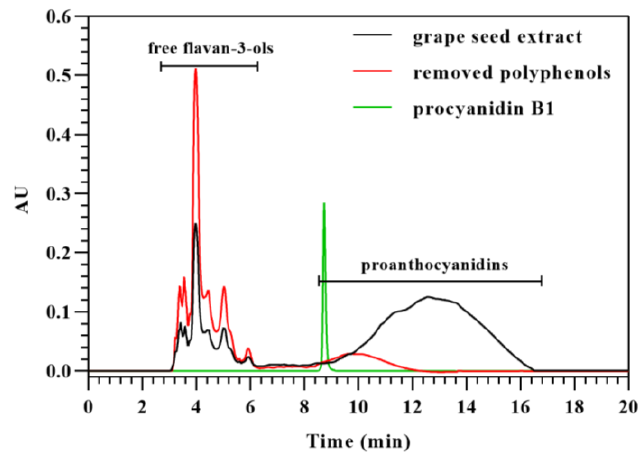
Figure 4. HPLC chromatograms of grape seed extract, removed polyphenols after purification of proanthocyanidins, and procyanidin B1, which were analyzed with HILIC based on their molecular weight.